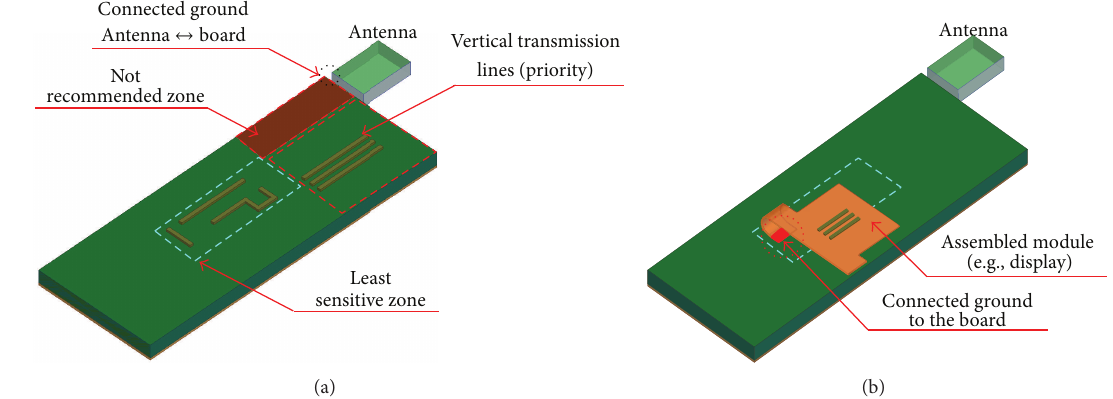
Figure 14: Proposed design guide for (a) transmission lines on the board, (b) the location of assembled module on the board.